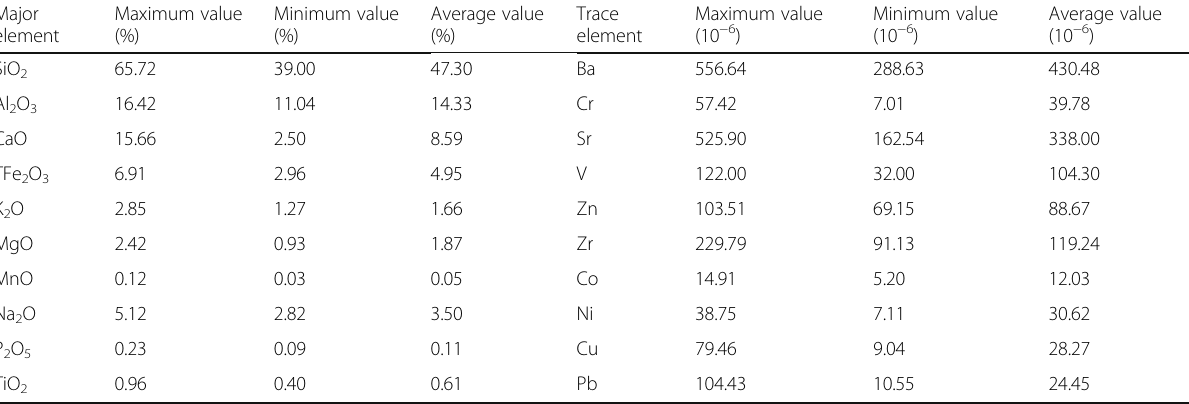
Table 2 Composition of major and trace elements of sediment from core SO184-10043 Major